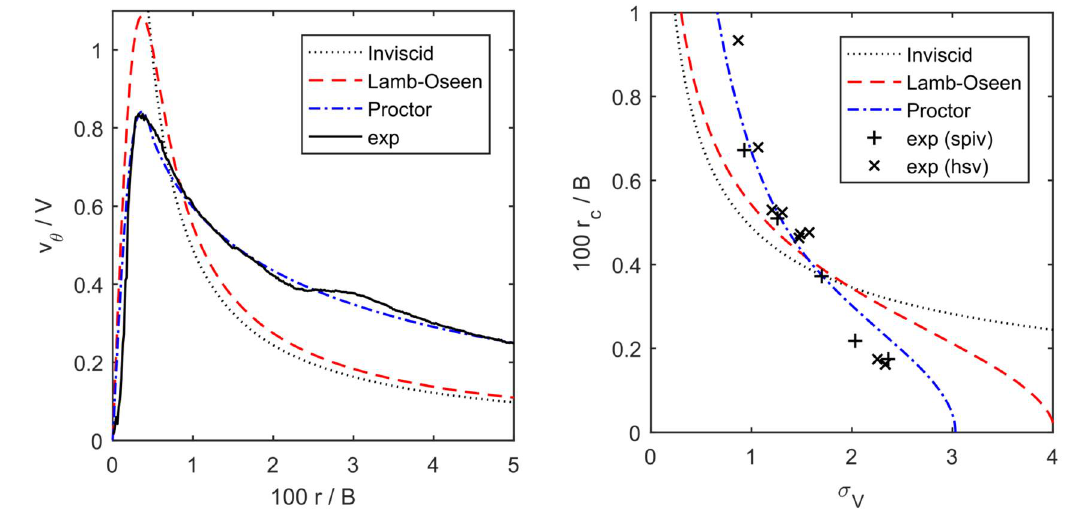
Figure 3. Measured and fitted azimuthal velocity distribution and cavity size variation for a wing of elliptical planform at 7 deg angle of attack. Experiments by Pennings et al. [29].